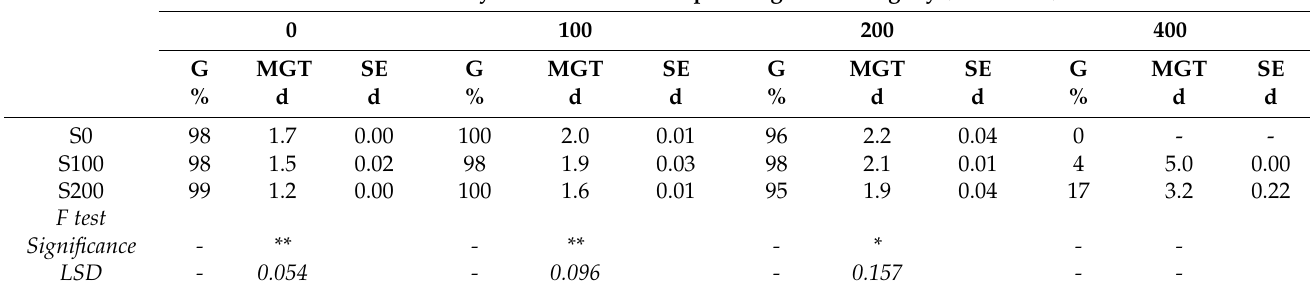
Table 2. Percentage germination (G) and mean germination time (MGT) for seeds harvested from mother plants grown with the three salinity treatments S0, S100 and S200 (i.e., 0, 100 and 200 mM of NaCl in the solution used for watering the pots throughout the whole growing cycle of the mother plants) and incubated in Petri dishes with 0, 100, 200 and 400 mM NaCl. SE is the standard